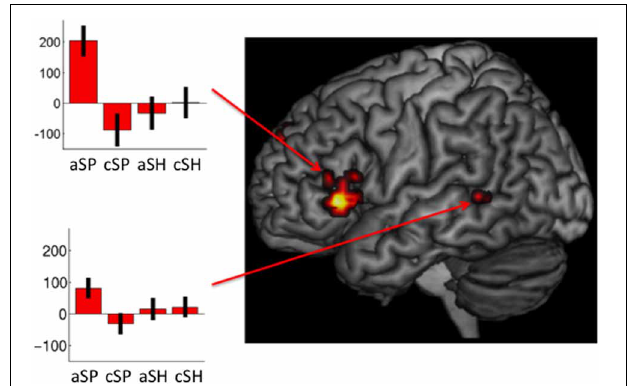
FIGURE 4 | Interaction of space-related co-verbal information processing and abstractness (whole-brain, p < 0 . 005, cluster